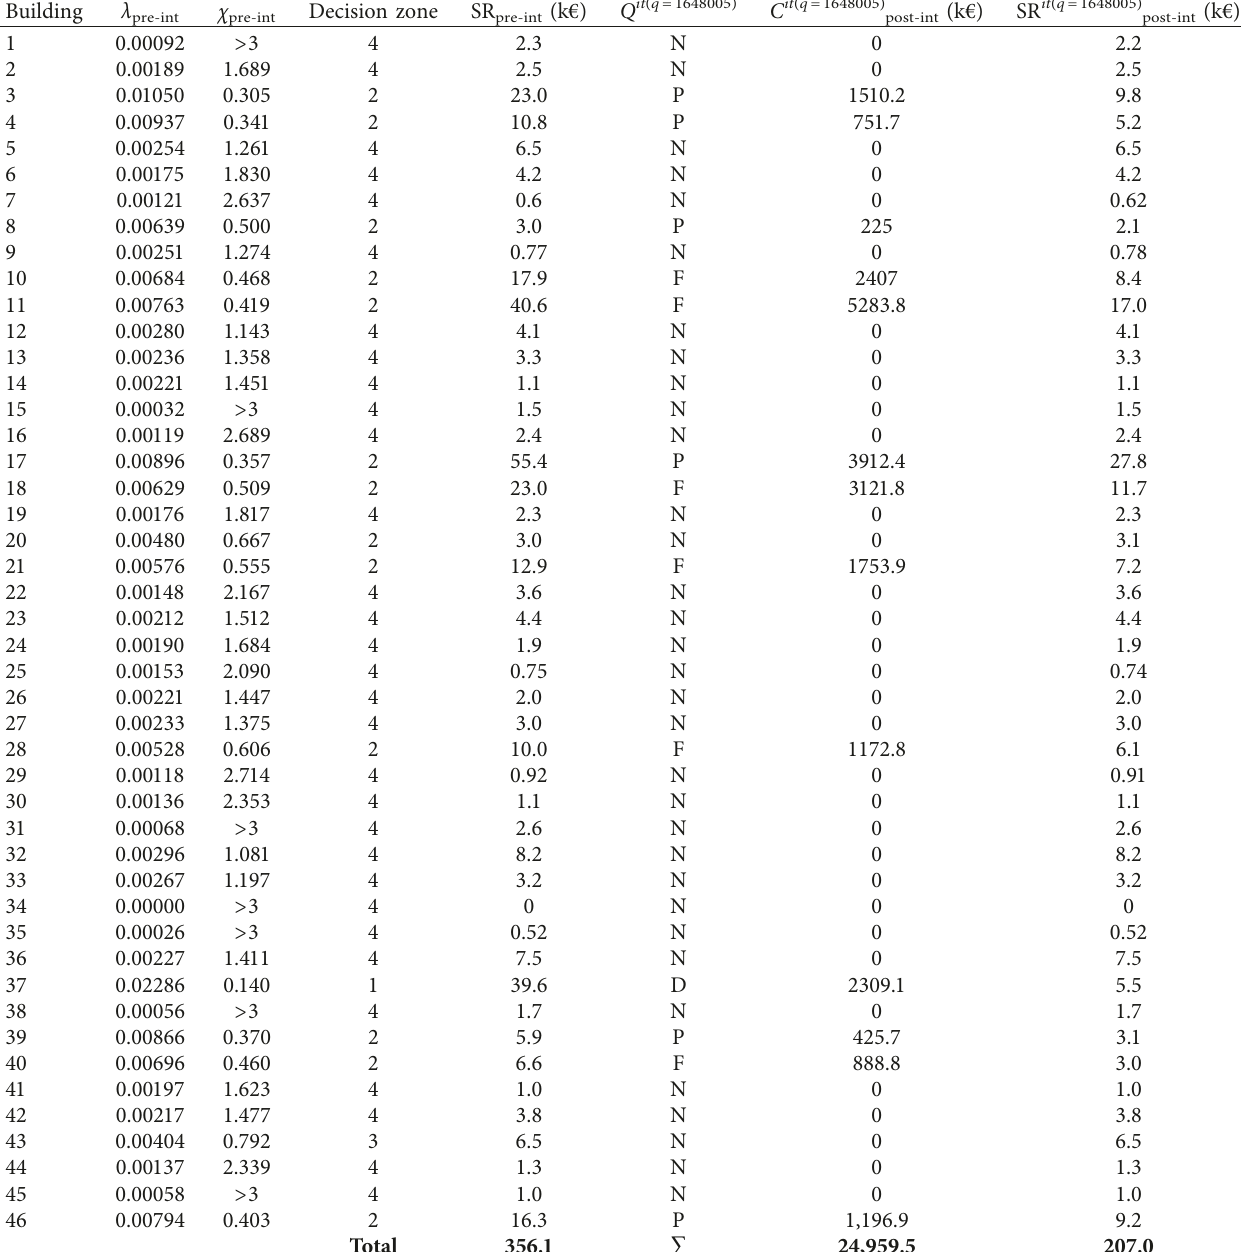
Table 4: Optimum budget allocations required to make the best possible structural intervention